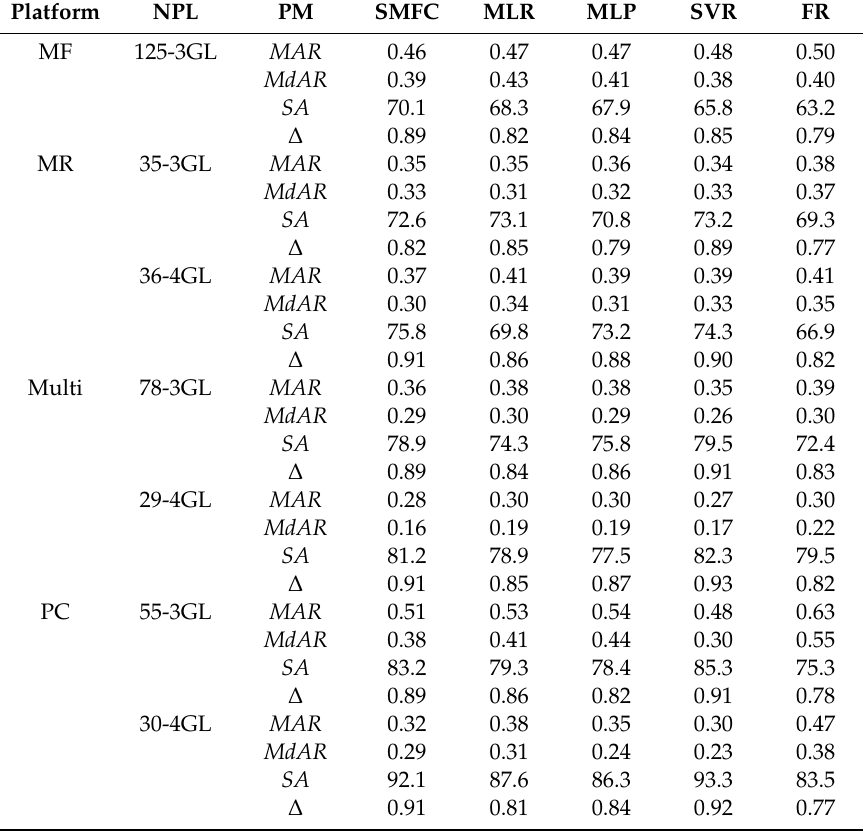
Table 6. Prediction performance by model (PM: performance